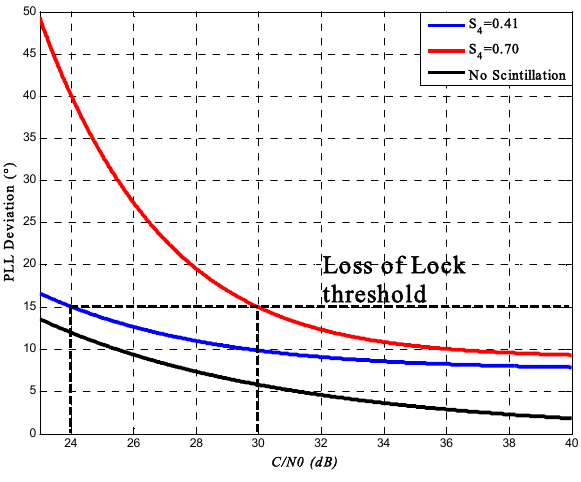
Figure 9. PLL standard deviation.